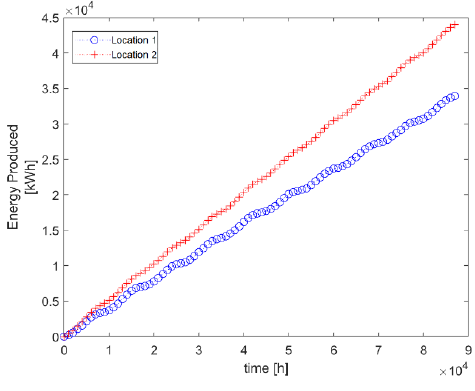
Figure 8. Energy produced.